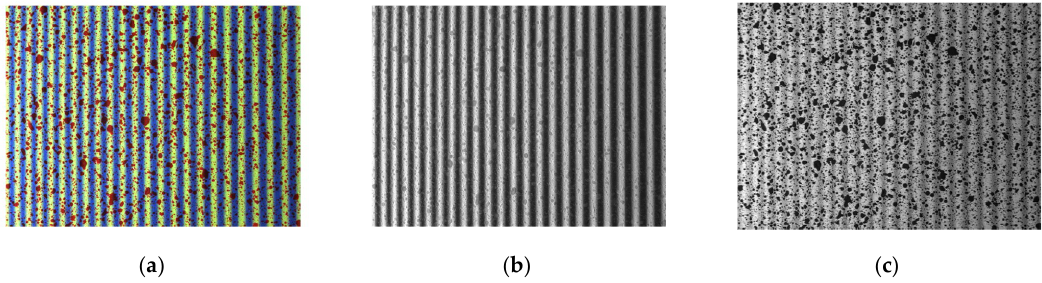
Figure 4 . Original image RGB decomposing process. ( a ) Original RGB image; ( b ) fringe image; ( c ) speckle image.